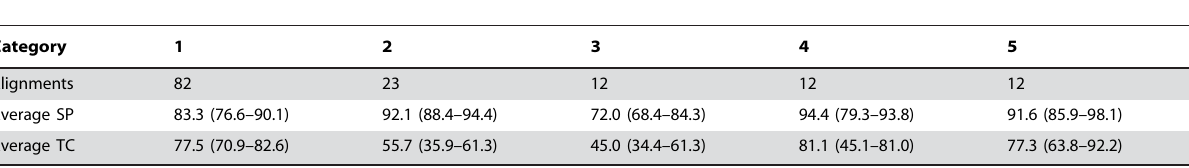
Table 3. Average GLAM 2 performance on each BAliBASE